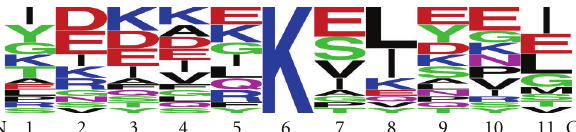
Figure 2: Sequence analysis of methylation sites in RNAP subunits. The frequency of each amino acid in an eleven-residue window centred on the modified lysine shows that there is no clear sequence specificity associated with methylation (generated by WebLogo